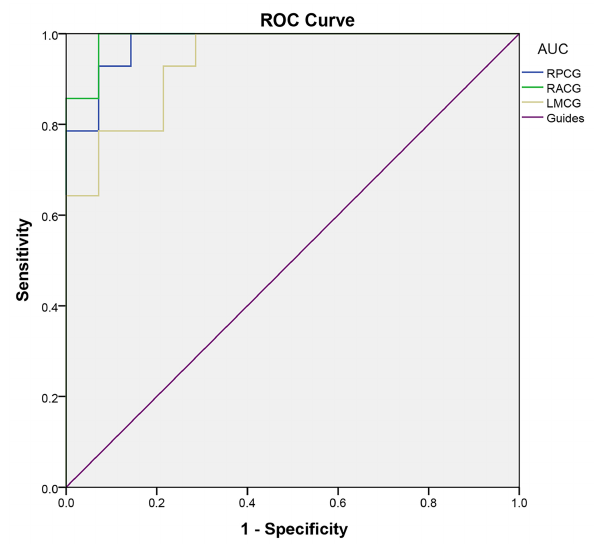
Fig. 3. ROC curves of the fALFF values for brain regions with sig- nificant differences between DON and HC groups. The AUC of fALFF valuesoftheRPCG,RACG,andLMCGwere0.980,0.990,and0.939respec- tively. ROC, receiver operating characteristic; fALFF, fractional amplitude of low-frequency fluctuation; DON, diabetic optic neuropathy; HC, healthy control; AUC, area under the curve; RPCG, right precentral gyrus; RACG, right anterior cingulate gyrus; LMCG, left middle cingulate